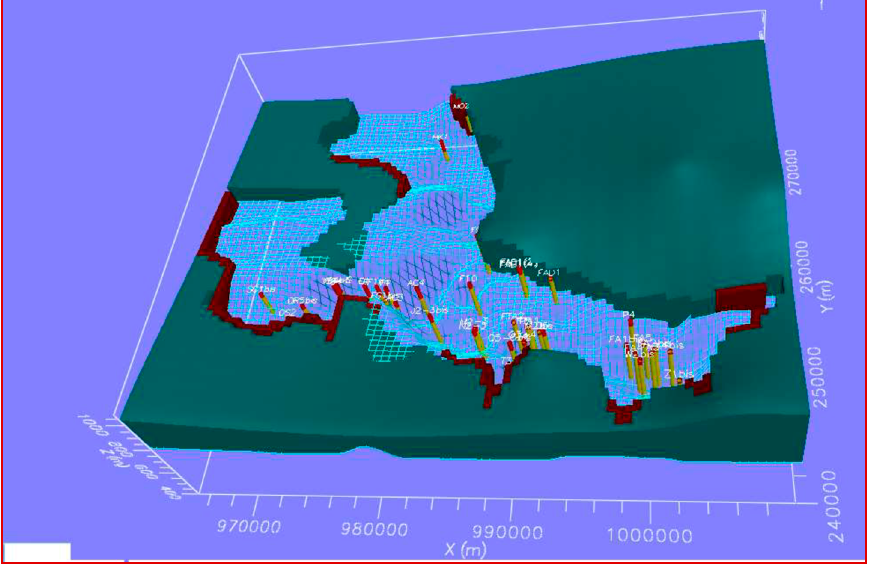
Figure 4. Cell discretization and boundary conditions of the Tebessa-Morsott alluvial aquifer